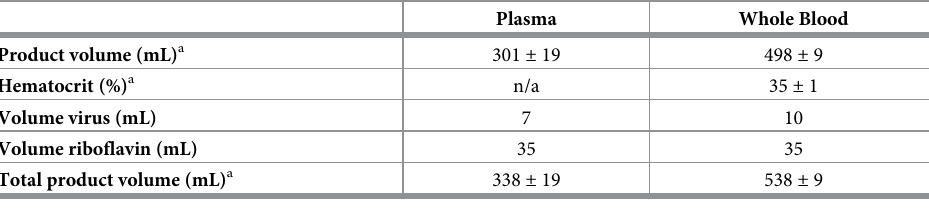
Table 2. Blood product